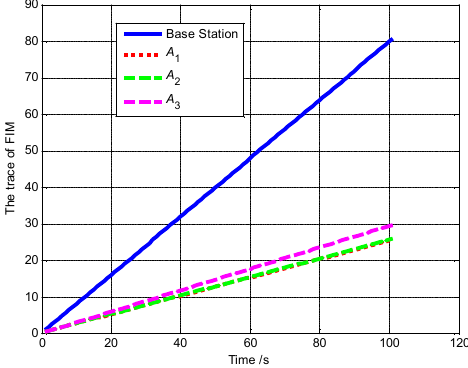
Figure 36. The trace of FIM of A 1 , A 2 , A 3 and base station (Scenario 4).